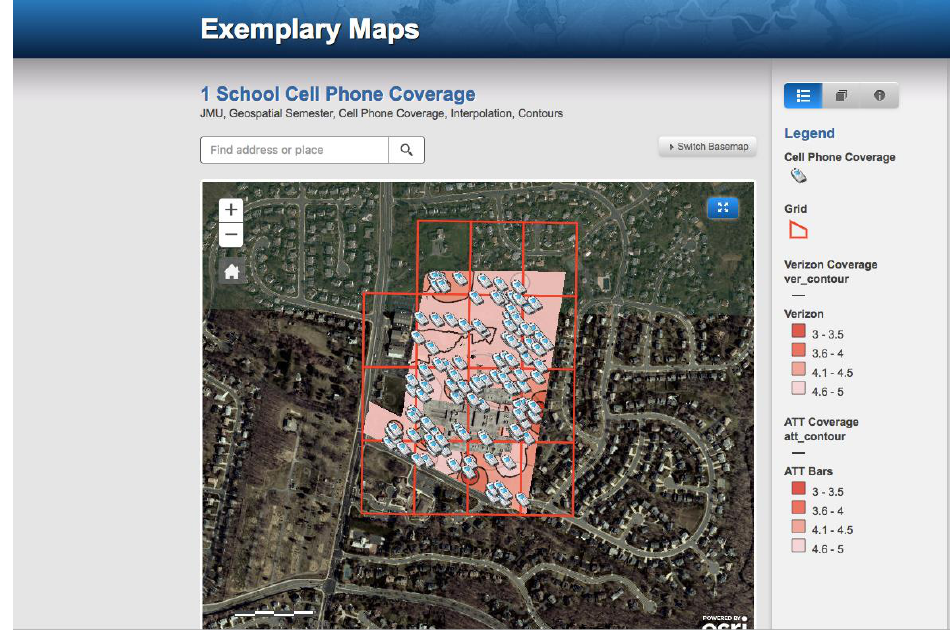
Figure 3. Cloud-based editable feature services (EFS) collected collaboratively to map campus cell phone coverage (http://kkoffice.maps.arcgis.com/apps/PublicGallery/map.html?appid= fdc75a0fc0e84a5b944f1b7fe96e0b2b&webmap=2bc61e7249694f508aa5e1bdfd6283e5).